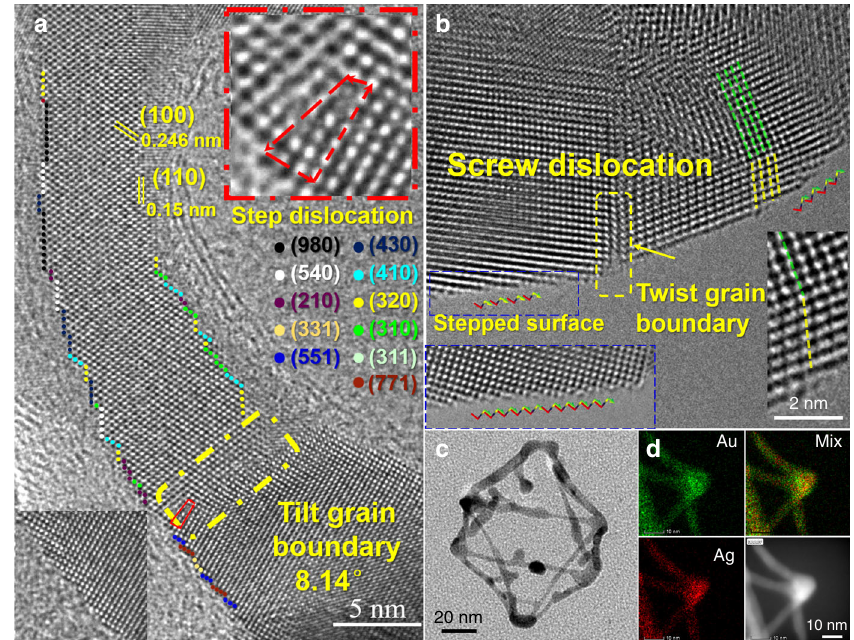
Fig. 2 Atomic structure of Au 3 Ag nanoframes revealing rich crystalline defects. a High-resolution lattice details on one of the edges displaying an edge dislocation, high-index surface atoms, point defects, and tilt grain boundaries. b High-resolution lattice details on one of the vertices displaying stepped surface atoms, screw dislocations, and twist grain boundaries. c Transmission electron microscopy (TEM) overview of the nanoframe. d Energy-dispersive X-ray (EDX) mapping images of Au and Ag on a vertex connecting four